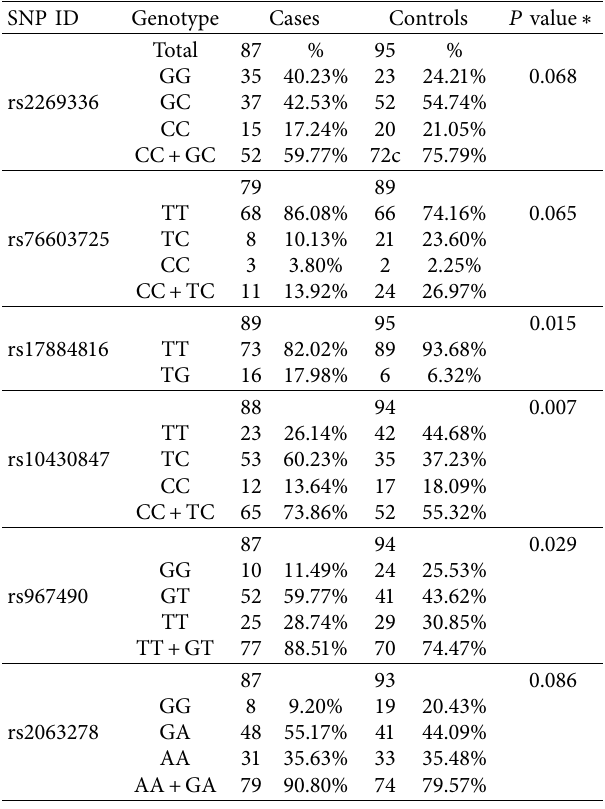
Table 2: Genotypes of selected SNPs and capsule